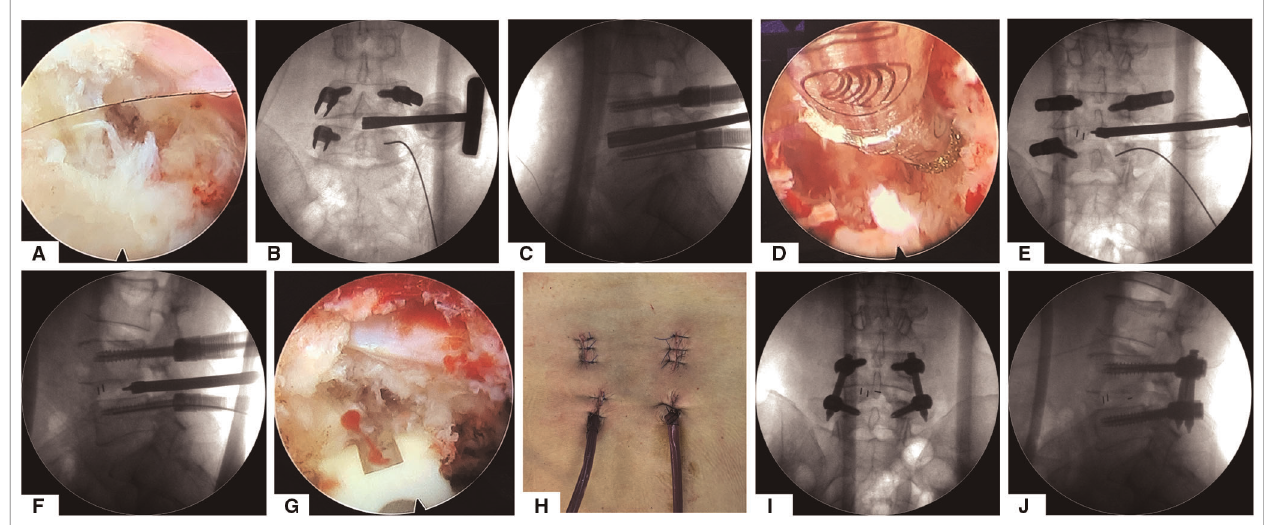
FIGURE 3 | The whole process of decompression and intervertebral disc treatment and implantation of intervertebral fusion cage under the visual channel. ( A ) Endoscope visual fi eld assisted by visual working channel after articular process osteotomy and decompression of the ligamentum fl avum. ( B , C ) The AP and lateral view of x-ray for discectomy by various paddle distractor. ( D ) Endoscopic view of endplate preparation by using turnable burrs. ( E , F ) Implant an intervertebral fusion cage under the guidance of AP and lateral view of x-ray. ( G ) Endoscopic view after implanting the intervertebral fusion cage. ( H ) General view of the postoperative incision. ( I , J ) AP and lateral view after surgery.